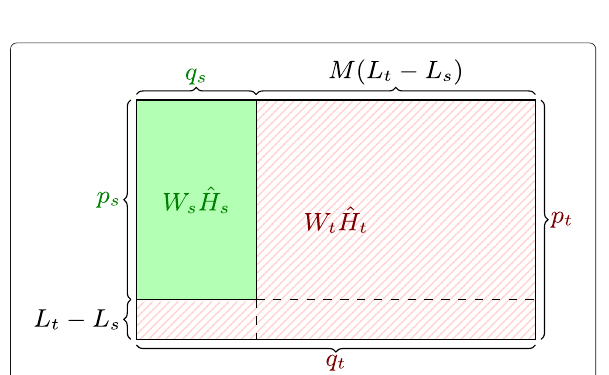
Fig. 2 Schematic illustration of the construction of the p s × q s -dimensional sub-matrix W s ˆ H s from the p t × q t -dimensional matrix W t ˆ H t